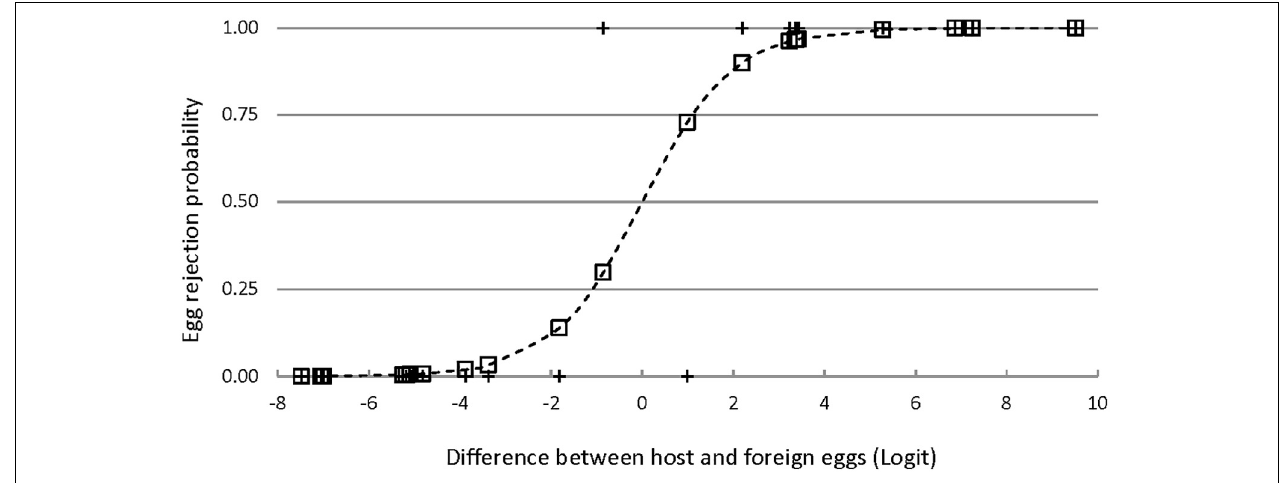
FIGURE 7 | Egg rejection by Rüppell’s weaver in relation to the difference between own and foreign eggs in a multiple logistic regression model ( ρ 2 = 0.80, P < 0.001) including three variables: eggshell ground brightness (mean% reflectance across the UV-VIS spectrum), spot brightness (8-bit grayscale, 0–255), and degree of spot aggregation near the broad pole of the egg (0–1). The logit values (X axis) integrate all three of these variables; the pluses indicate the observed responses (acceptance = 0, rejection = 1); and the squares indicate the probability of egg rejection for each instance of experimental parasitism as predicted by the